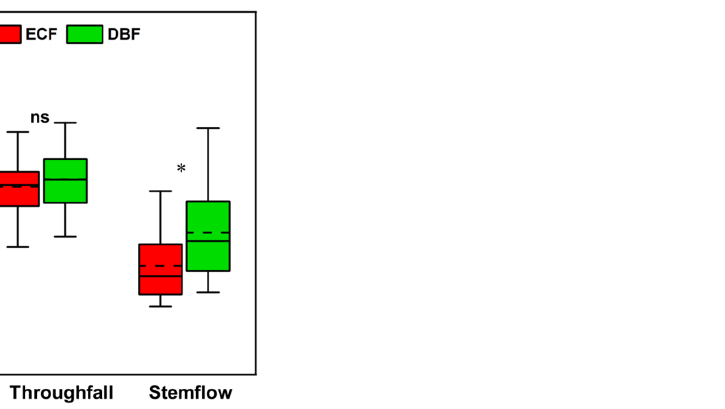
Figure 4. Annual average pH of bulk rainfall, stemflow, and throughfall. The data from 23 rainfall collections in 2015. Solid and black dashed lines, box boundaries, and bars represent median and mean values, 25th and 75th, and 5th and 95th percentiles of all data, respectively. * indicates significant differences in pH between the ECF and DBF at the 0.05 level; ns, not significant in pH between the ECF stand and the DBF stand at the 0.05 level. OAF: open area field; ECF: evergreen coniferous forest; DBF: deciduous broadleaved forest.